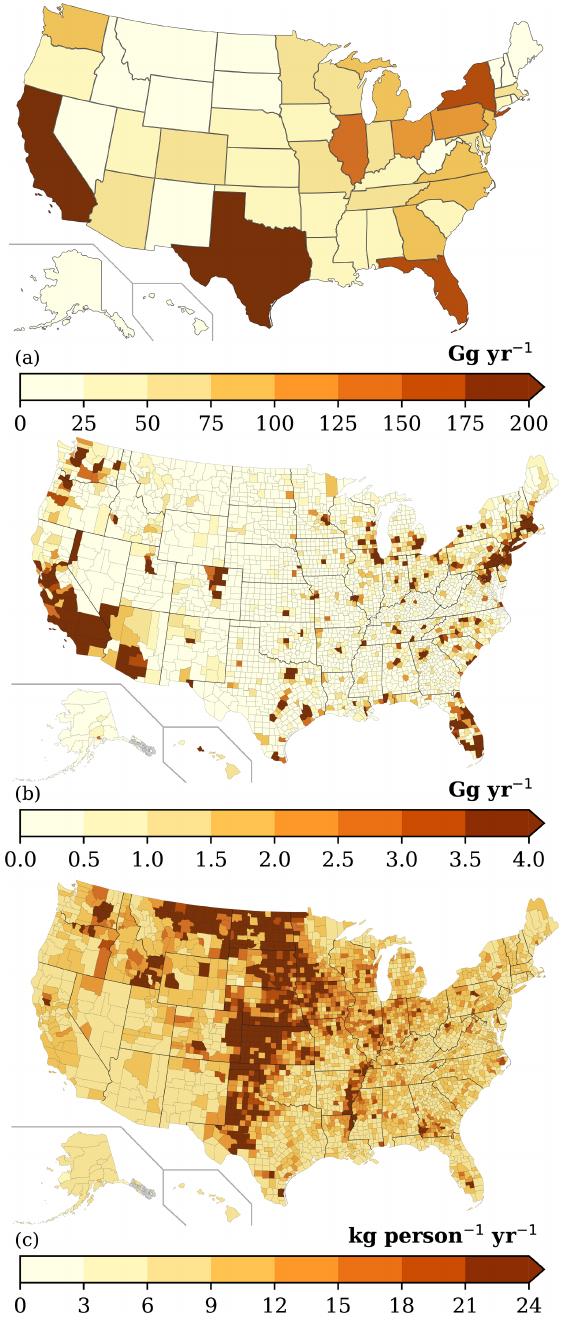
Figure 5. (a) State-level, (b) county-level, and (c) county-level per capita VCP